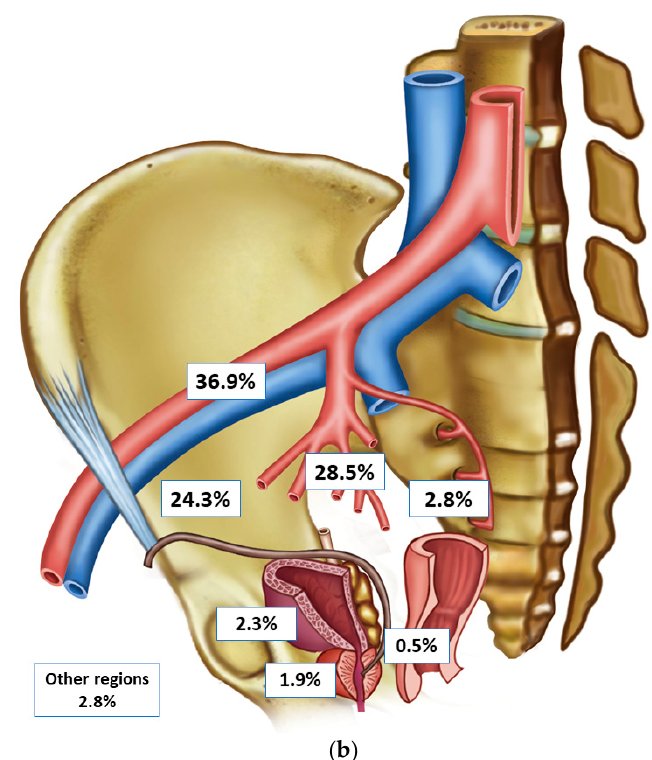
Figure 2. ( a ) areas and anatomical distribution of lymph node metastases ( n = 214) detected by extended pelvic lymph node dissection and/or magnetometer-guided sentinel lymphadenectomy after intraprostatic injection of superparamagnetic iron oxide nanoparticles in 61 lymph node-positive patients with high-risk prostate cancer; ( b ) distribution and localization of lymph node metastases in an anatomical pelvic model. * Mean values and standard deviations (SD) on a patient level.